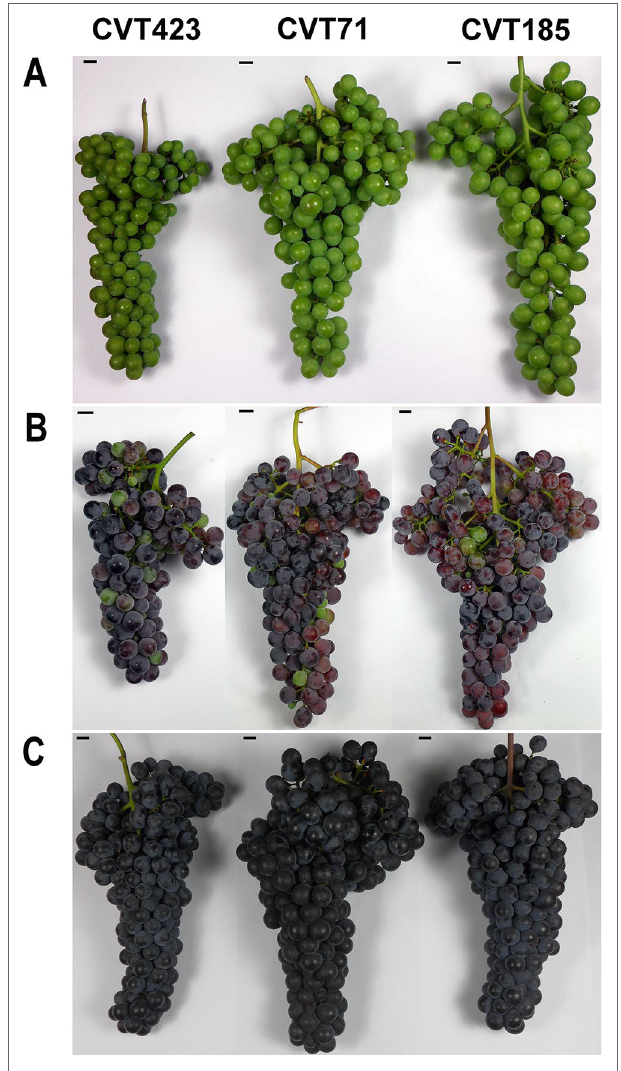
FIGURE 1 | Phenotypic details of the grapes from CVT423, CVT71, and CVT185 "Nebbiolo" clones around pre-véraison (A) , véraison (B) , and harvest (C)